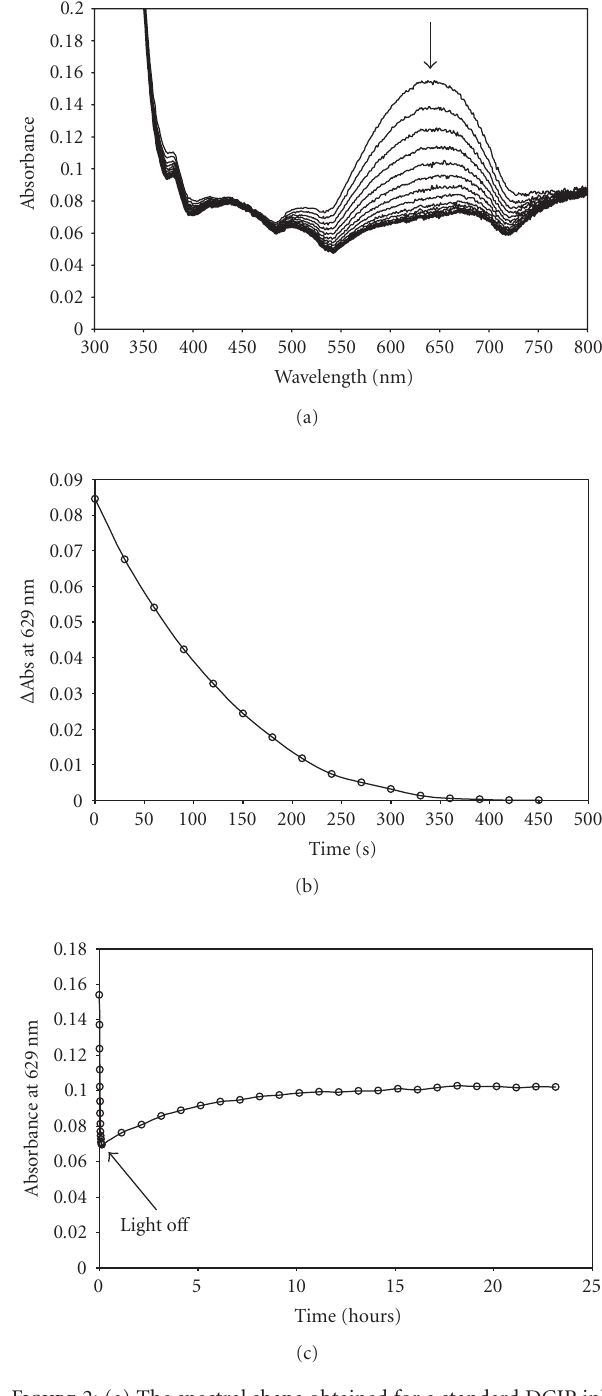
Figure 2: (a) The spectral shape obtained for a standard DCIP ink cast on the surface of Activ, and the subsequent changes (from top to bottom) in this spectral shape as the sample is irradiated with UVA light at an intensity of ca. 4.8mW cm − 2 . Spectra were recorded at 30-second intervals. (b) The change in the absorbance ( Δ Abs) at λ max (629 nm) with UVA irradiation of a DCIP ink, based on the data presented in Figure 2(a). (c) The reduction, and subsequent recovery, of a DCIP ink on the surface of Activ at 629 nm. The reduction conditions were similar to those detailed previously in Figure 2(a), whereas the ink recovery was monitored in the dark with spectra recorded at 1 hour